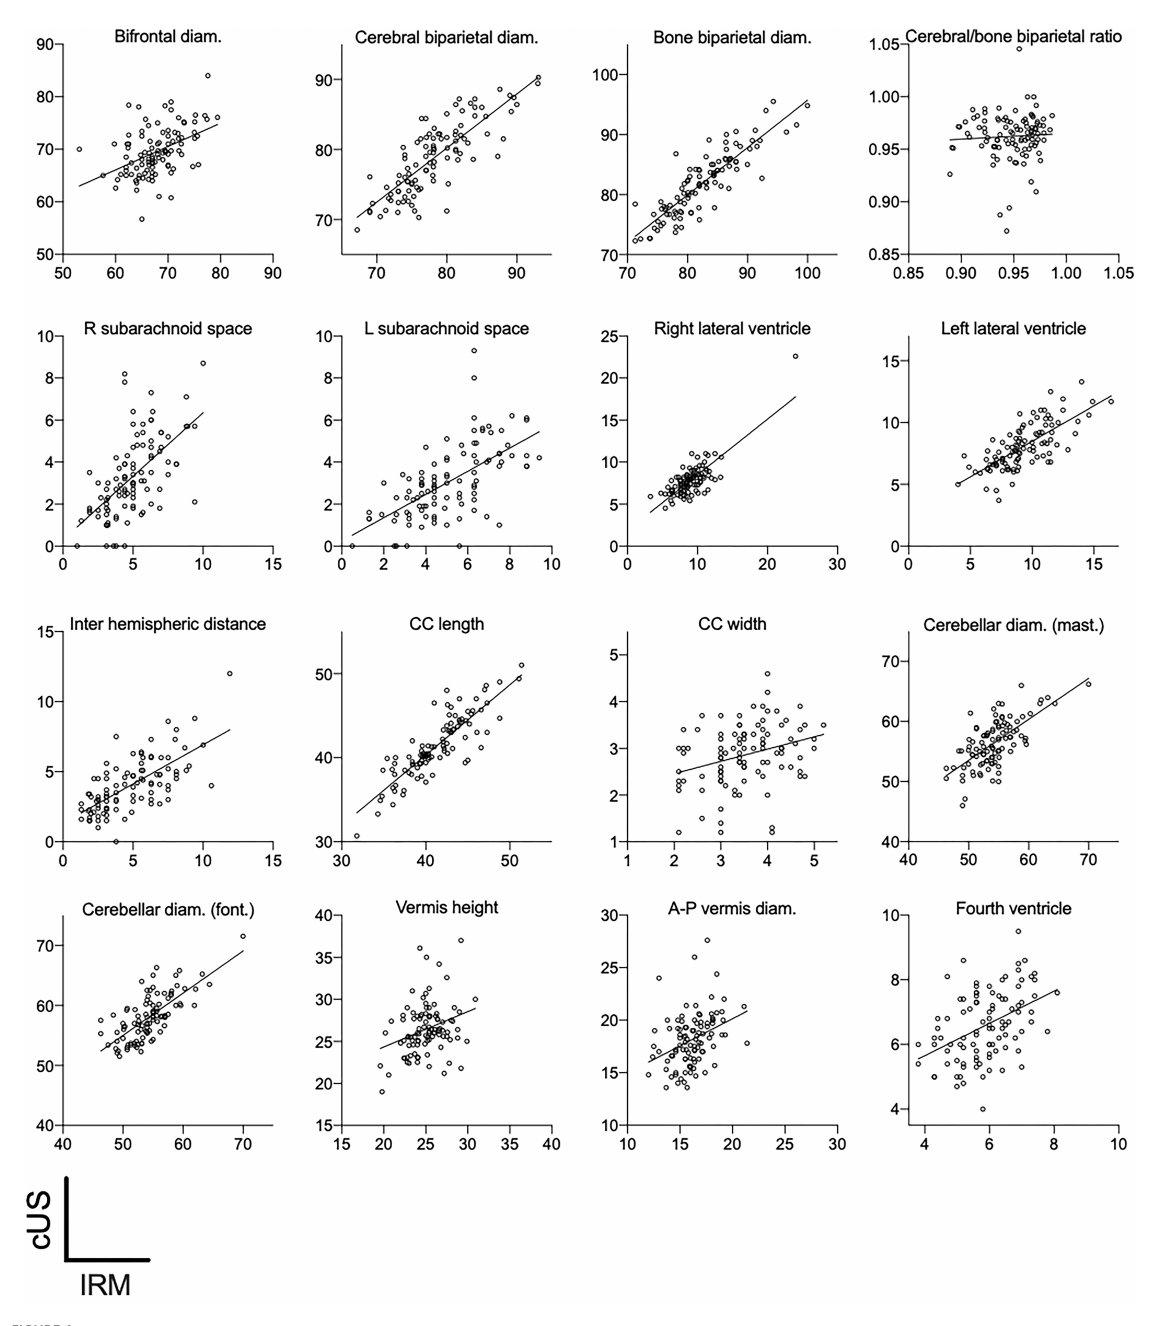
FIGURE4 cUS vs. IRM 2D metrics. All measurements are expressed in millimeters. Diam, indicates diameter; R, right; L, left; mast, mastoid window; font, anterior fontanel window; CC, corpus